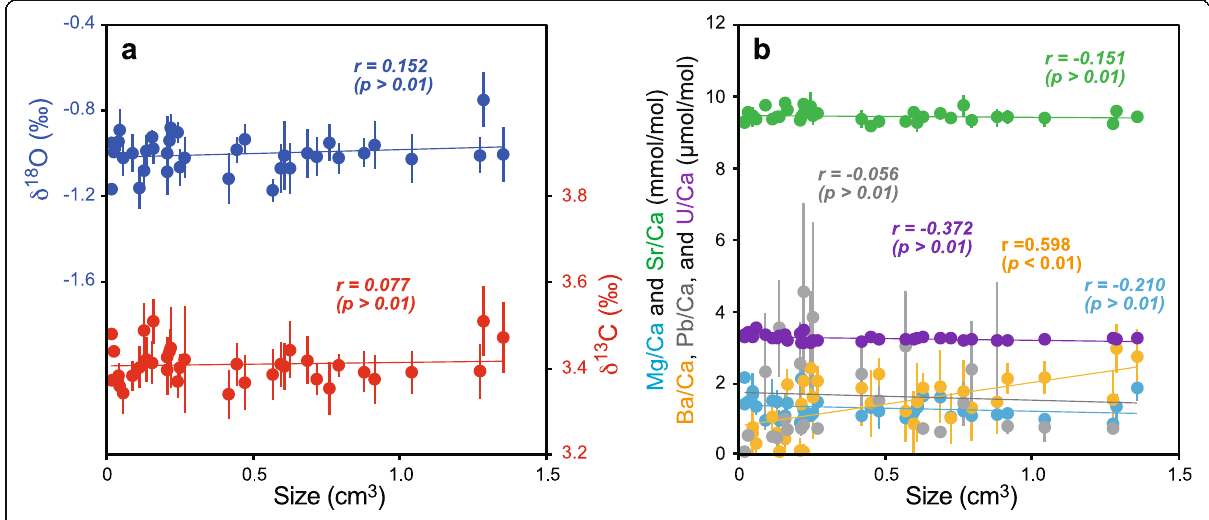
Fig. 9 Relationship between sample size and a δ 18 O and δ 13 C and b elements/Ca ratios of